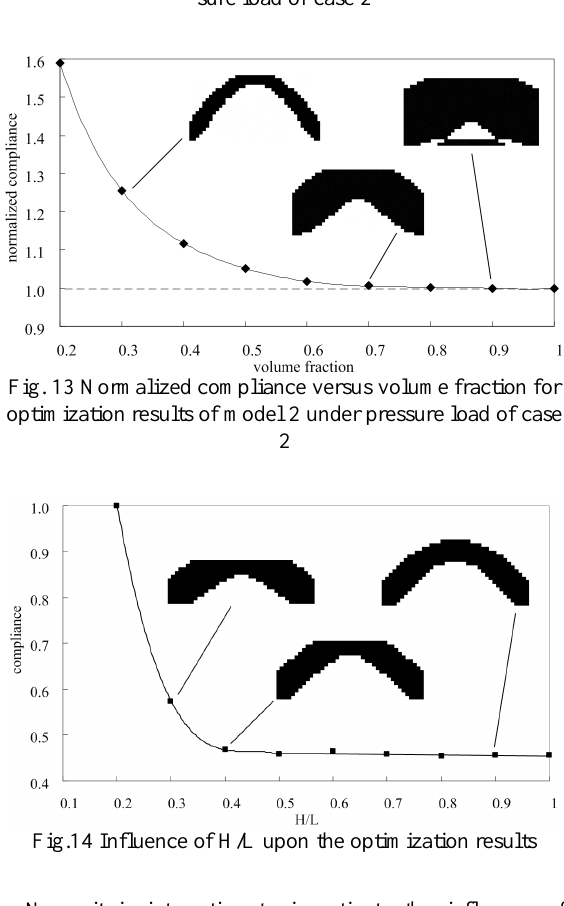
Fig. 15 2D optimal configurations of model 3 under pres- sure load of case 2